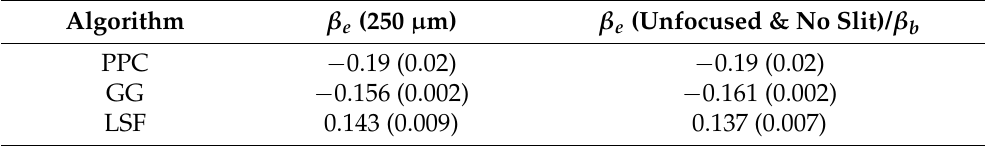
Table 1. Extracted contrasts by the the three algorithms. The error bar is included in the parenthesis.